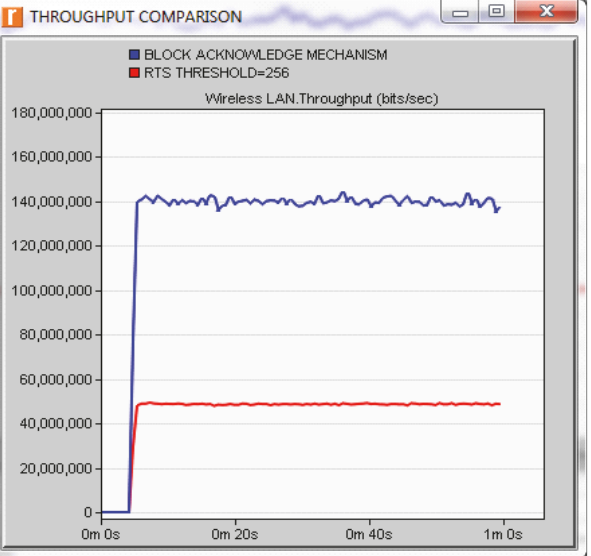
Figure 7: WLAN throughput comparison for block acknowledge- ment versus RTS mechanism.